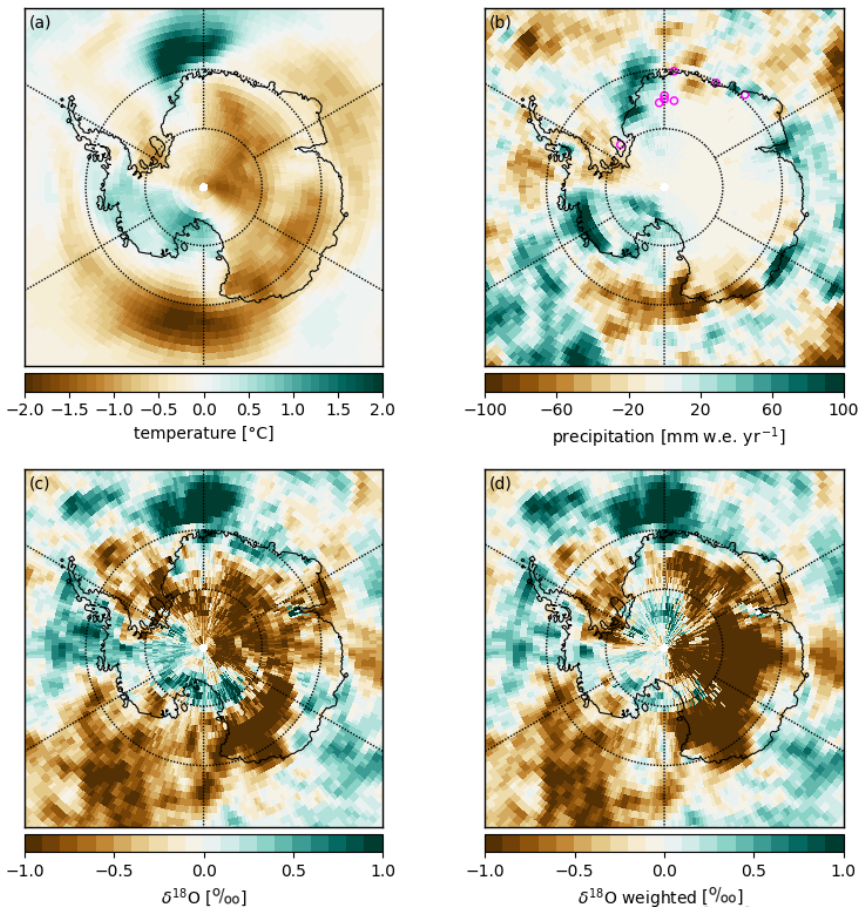
Figure 4. Anomaly of (a) annual mean temperature ( ◦ C), (b) precipitation (mm w.e.yr − 1 ), (c) mean δ 18 O of precipitation (‰) and (d) mean δ 18 O weighted by the precipitation amount (‰) averaged over the 1974–1976 period compared with the 1958–2000 period in a simulation performed with ECHAM5-wiso. The circles in panel (b) correspond to the location of the ice cores in Table 1 with the B40 core shifted northward by 0.6 ◦ in order to avoid an overly large overlap with nearby